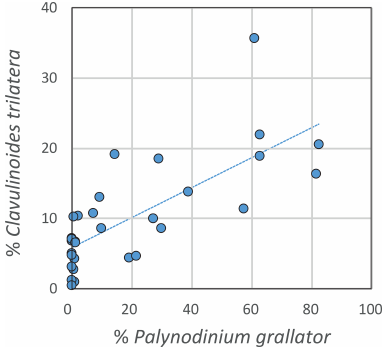
Figure 7. Correlation between the relative abundances of Pa- lynodinium grallator and Clavulinoides trilatera ( R 2 = 0 . 55; p - value <